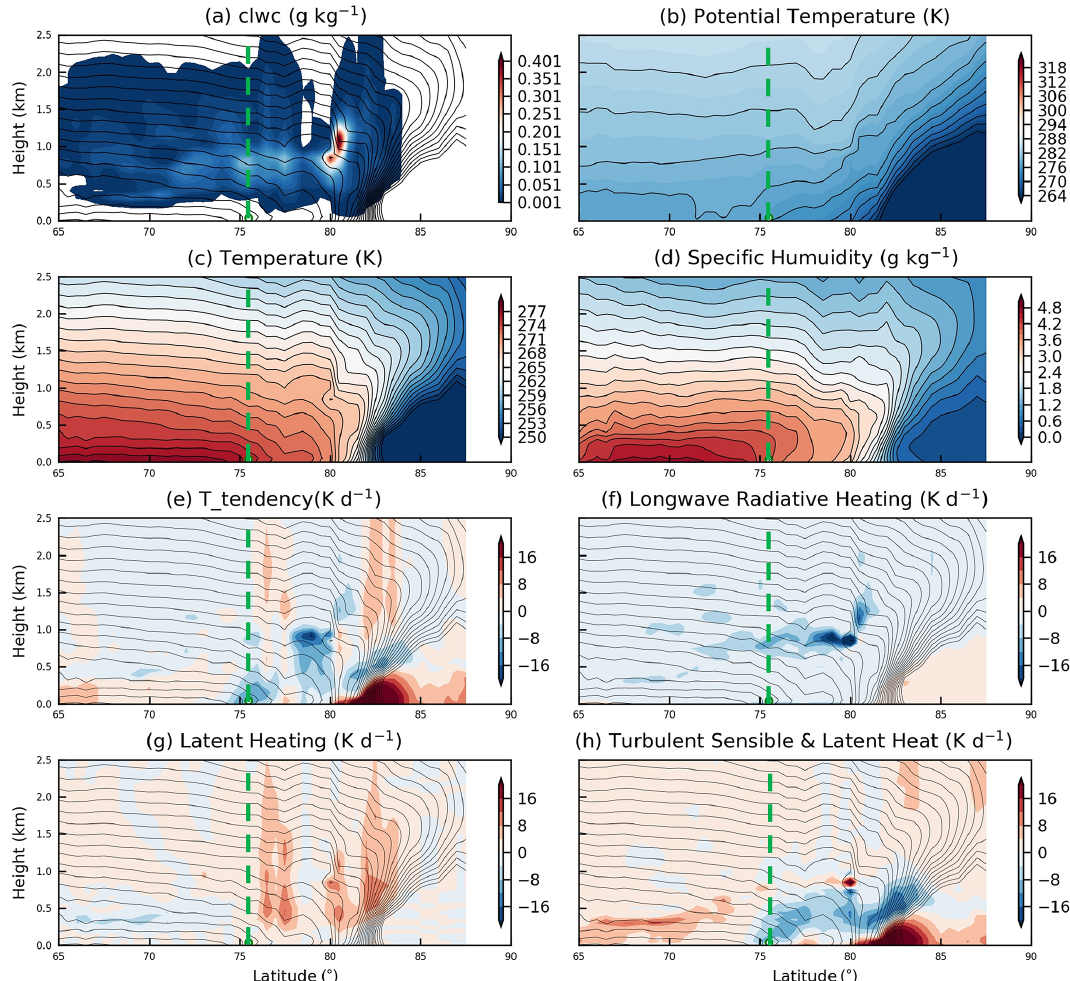
Figure 14. Same as Fig. 11 but for a selected turbulence-dominated WaMAI with cold